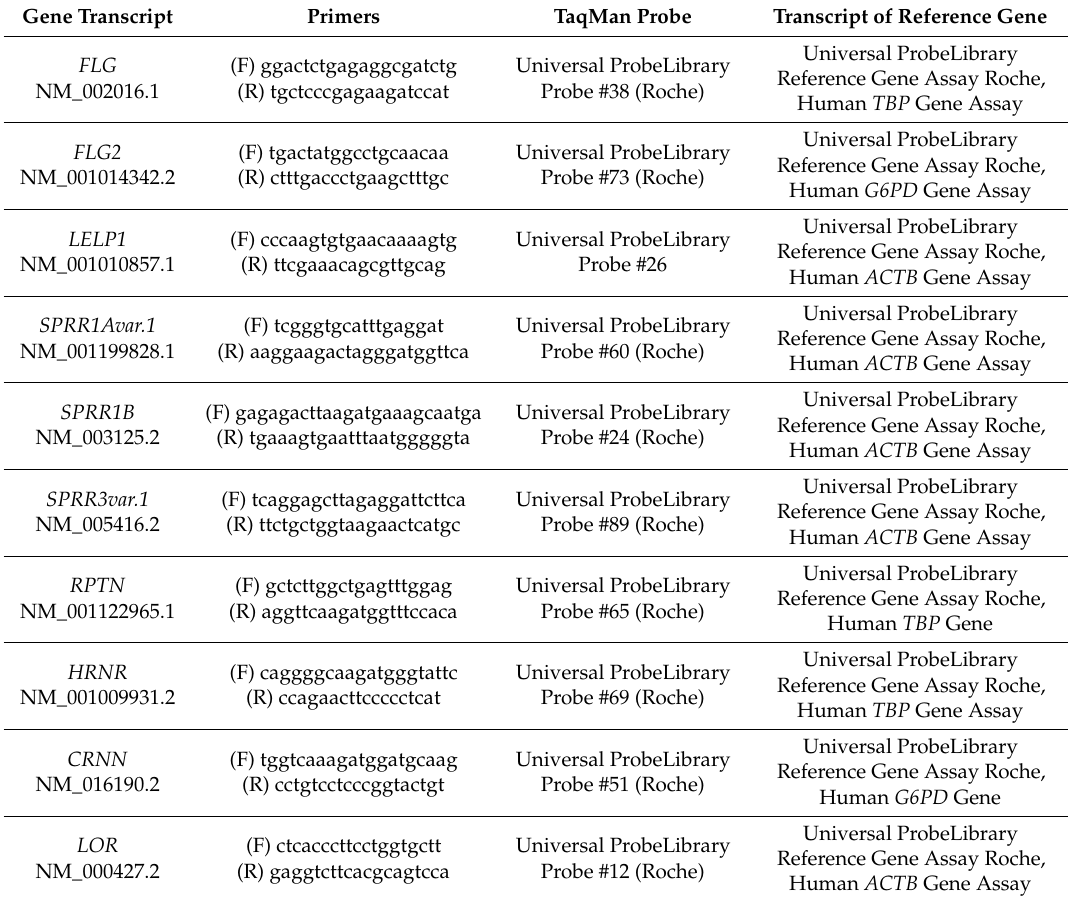
Table 1. Gene transcript, primers and TaqMan probes used for real-time polymerase chain reaction